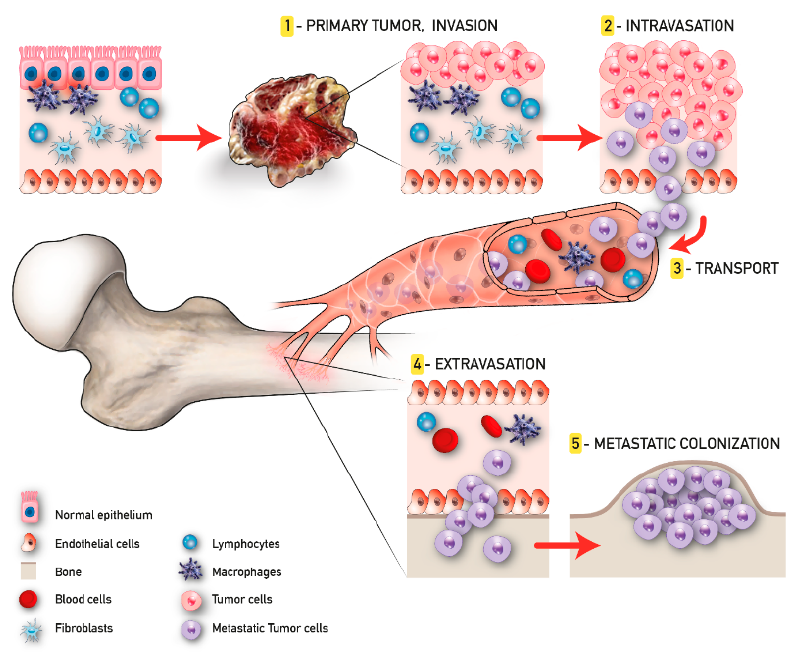
Figure 1. Tumor progression and bone metastasis process.